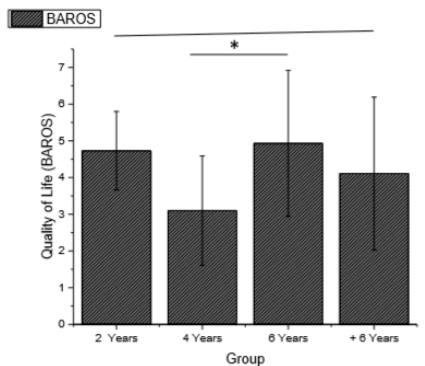
Figure 5. Quality of life in different groups ( p = 0.049, f 2 of Cohen = 0.099). Changes in biochemical marker levels are shown in Table 4. LDL and total cholesterol levels significantly improved postoperatively in BS2, BS4, and BS+6. Triglyceride levels improved significantly in all groups and glycemia levels significantly improved in BS +6.